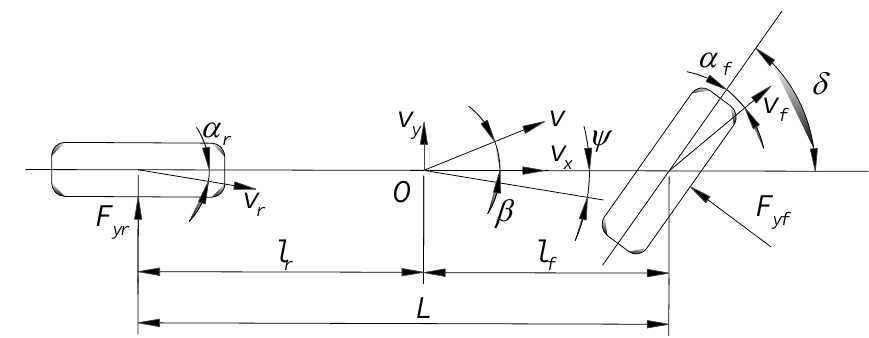
Figure 1. Two degrees-of-freedom (2-DOF) vehicle model.